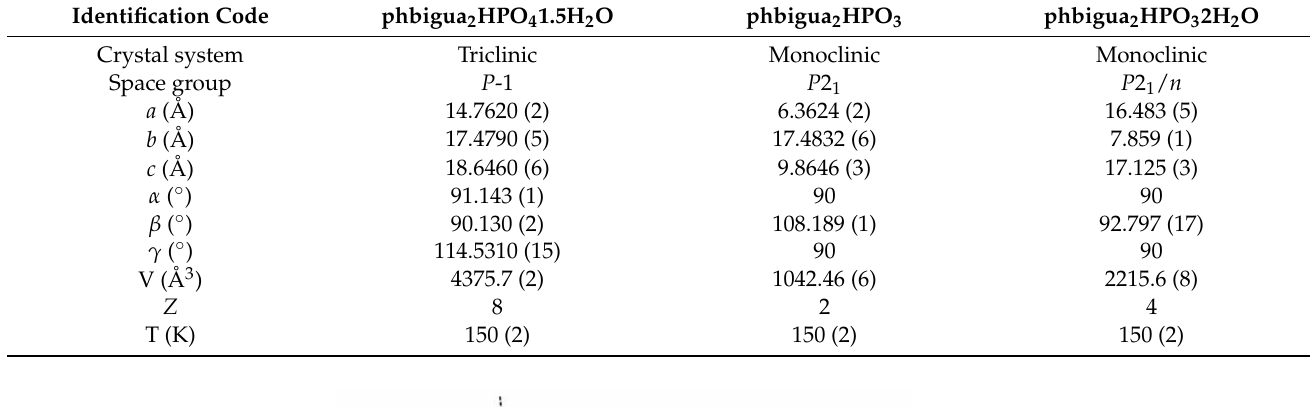
Table 2. Basic crystallographic data of phbigua 2 HPO 4 1.5H 2 O , phbigua 2 HPO 3 , and phbigua 2 HPO 3 2H 2 O .